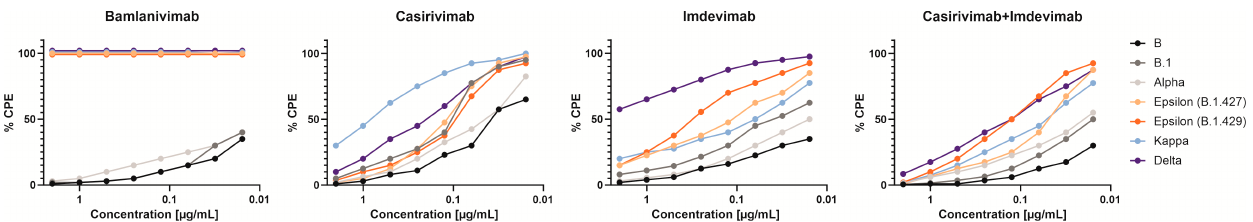
Figure 2. Neutralization efficacy of monoclonal antibodies against SARS-CoV-2 variants. Serially diluted (1:2) monoclonal antibodies (mAbs) were incubated with the indicated SARS-CoV-2 variants. Cytopathic effect (CPE) formation was analyzed after 72 h. Average values of 16 biological replicates (except n = 8 for bamlanivimab) are depicted. Using A549-AT cells, CPE formation was microscopically evaluated. Physiological concentrations of mAbs were applied according to the manufacturer’s instructions.